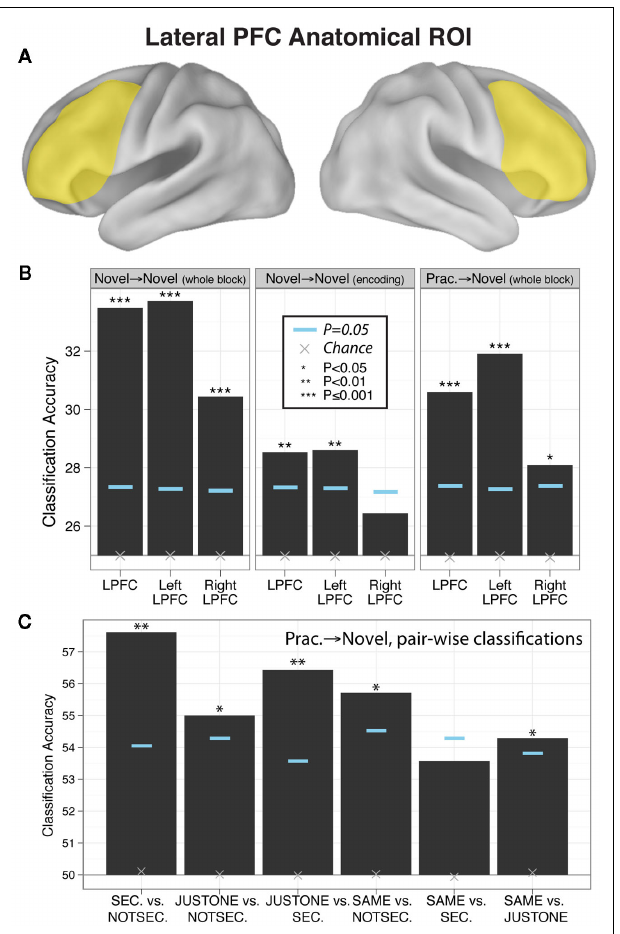
FIGURE 2 | Evidence of practiced-to-novel transfer of context-independent decision rule representations within LPFC. (A) Location of the anatomical LPFC ROI. (B) Classification accuracies across the four rules using the anatomically defined LPFC ROI for whole novel blocks, novel task encoding periods, and practiced → novel (classifier trained on practiced blocks, tested on novel blocks). Significance was assessed using permutation tests. Left and right LPFC accuracies were significantly different for the novel → novel whole block ( p = 0.006) and practiced → novel ( p = 0.02) classifications (based on permutation tests). (C) Pair-wise classifications across the six between-rule comparisons ( practiced → novel ) underlying the four-way classifications.